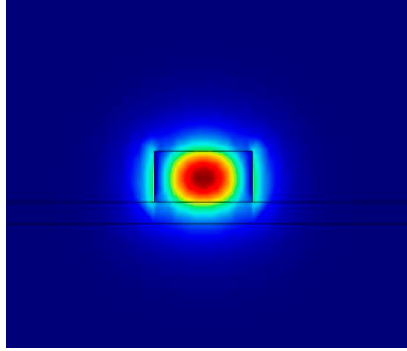
Figure 2. Field distribution of the electromagnetic field in the strip waveguide.